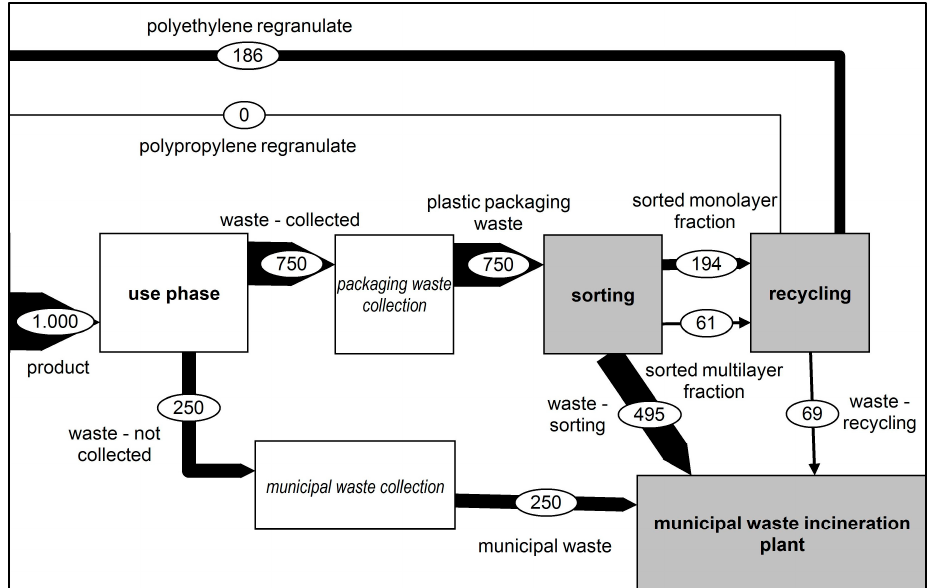
Figure 3. Representation of material flows—Status Quo Scenario. Composition of the functional unit and the utilisation from van Eygen et al., 2018 [5].